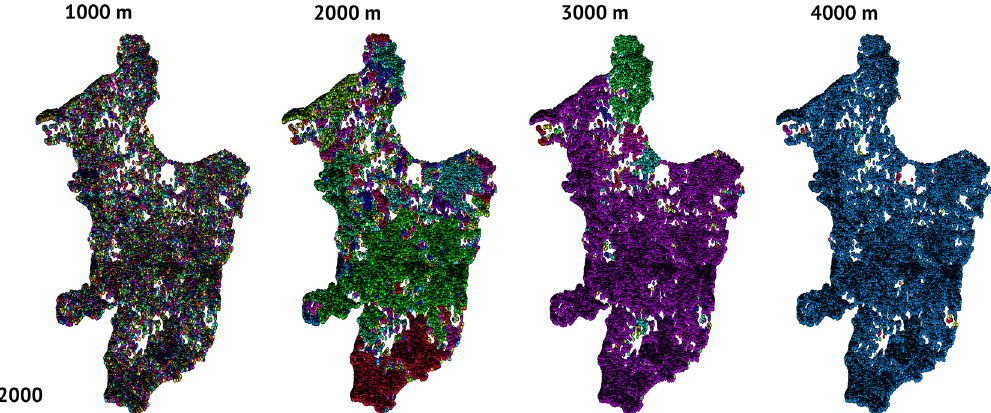
Figure 4. Comparison of global coalescence based on different dispersal distances (1000 m, 2000 m, 3000 m, 4000 m, 5000 m) comparing the patterns of clusters for 2000. Remnant centroids are shown as colored points. If two or more remnants are within the indicated dispersal distance from each other, they are denoted with the same randomly chosen color to indicate that they are part of the same cluster. Networks built with dispersal distances < 1000 m had too many isolated nodes that were too far apart to form clusters to discern any patterns. Figures were generated using RStudio.